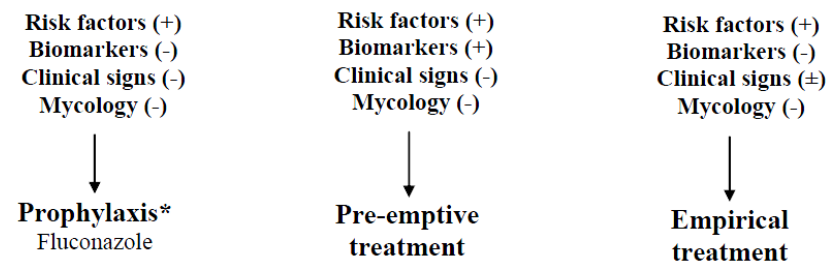
* Prophylaxis is specific ICU